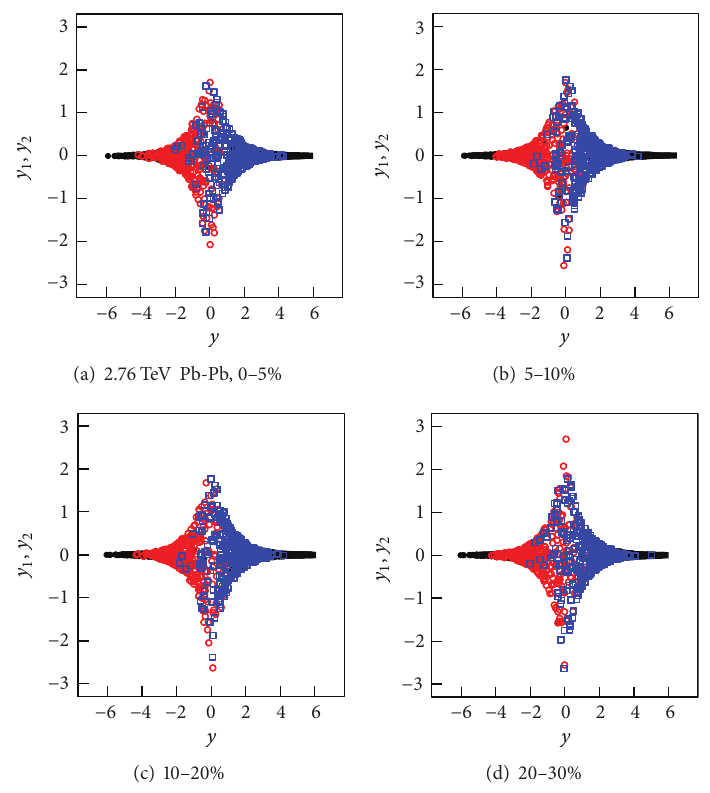
Figure 5: The same as for Figure 4, but showing the results in the rapidity space 𝑦 1 − 𝑦 (or 𝑦 2 − 𝑦 ).